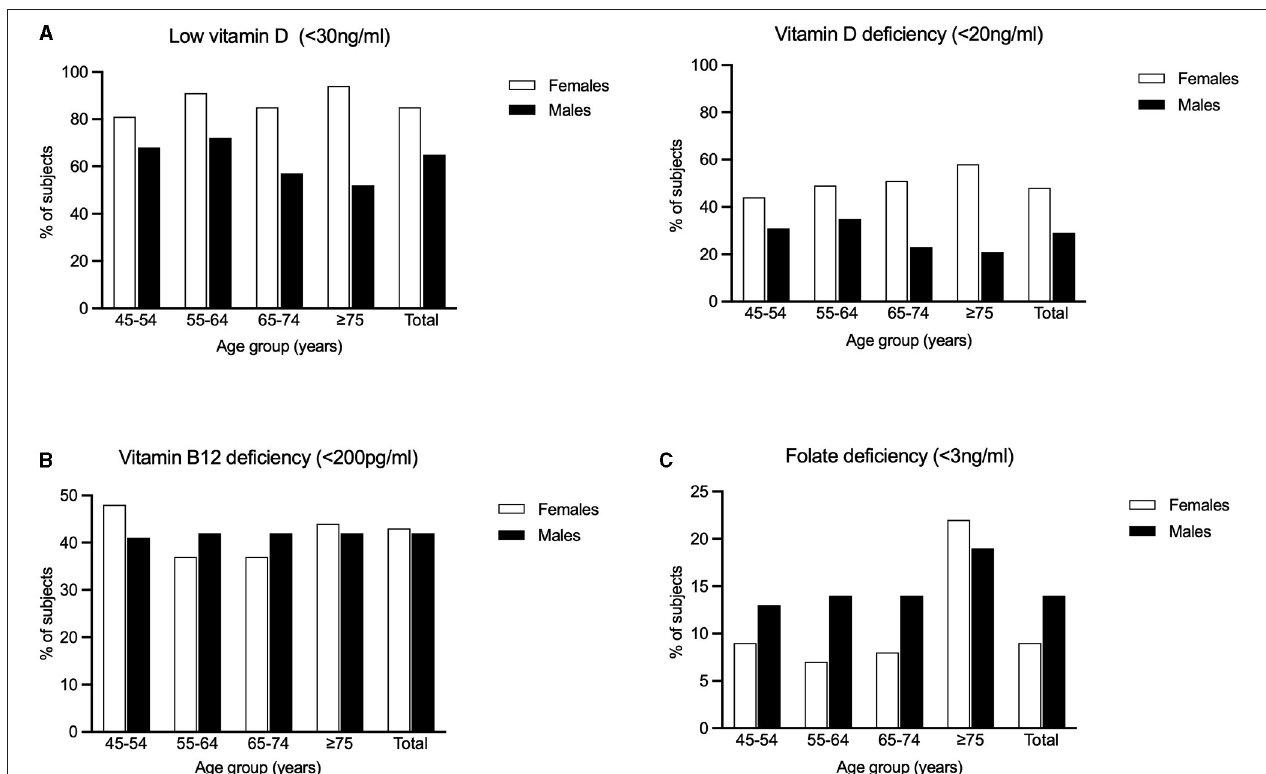
FIGURE 2 | Percentages of the study population having (A) Low Vitamin D ( < 30ng/ml) and Vitamin D deficiency ( < 20ng/ml) (B) Vitamin B12 deficiency and (C) Folic acid deficiency is graphically represented.